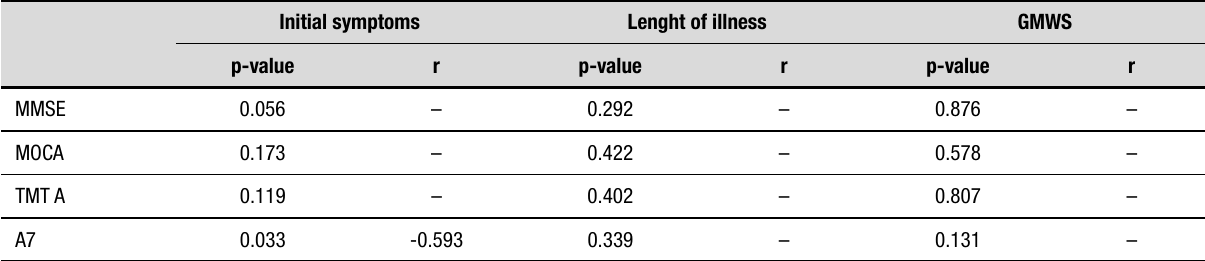
Table 4. Correlations between cognitive tests and clinical